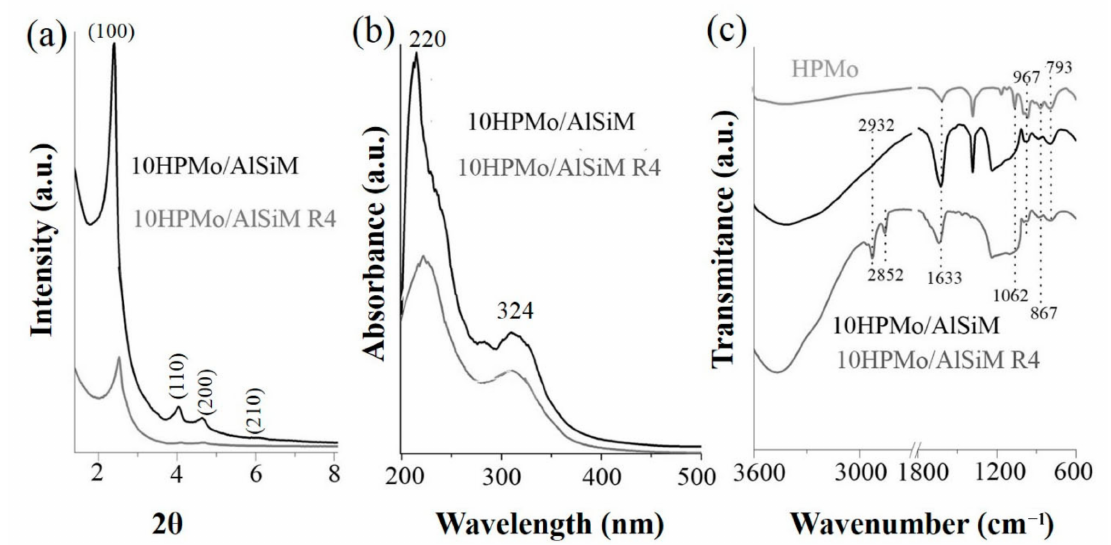
Figure 2. ( a ) Comparison of XRD standards, ( b ) DRS spectra, ( c ) FTIR spectra of the new catalyst and after the fourth reuse cycle. R: refers to the reused